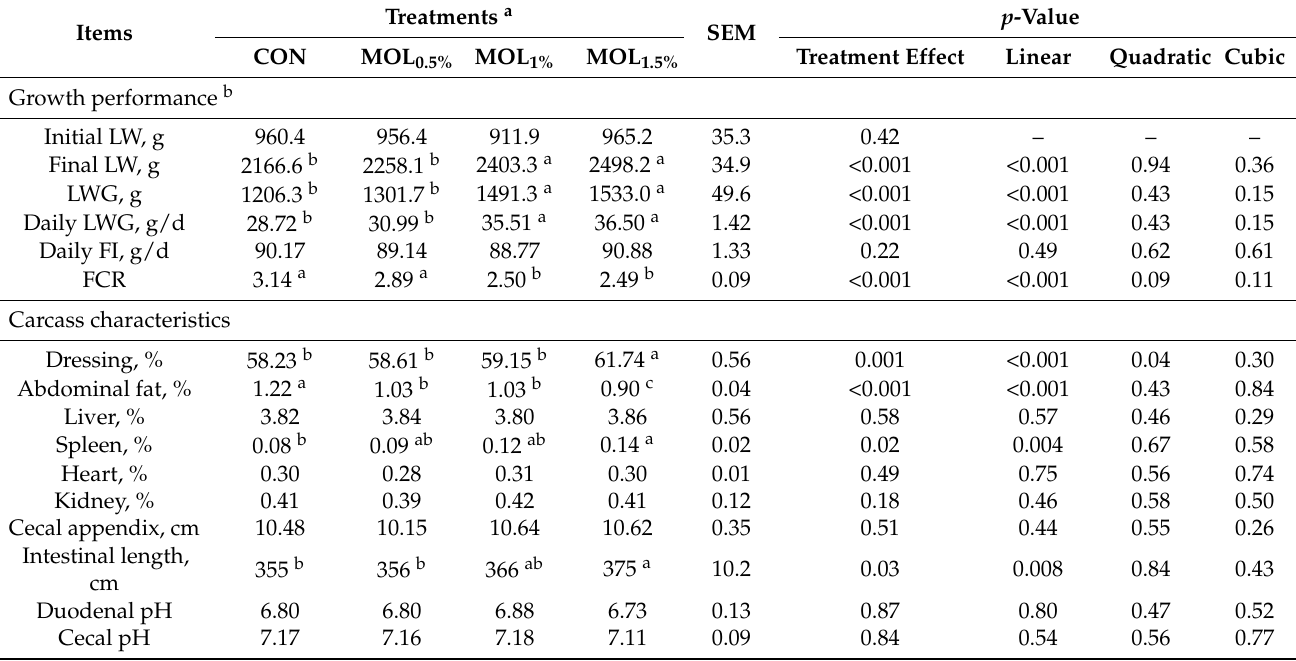
Table 3. Growth performance and carcass traits of growing rabbits fed the control and treatment diets.